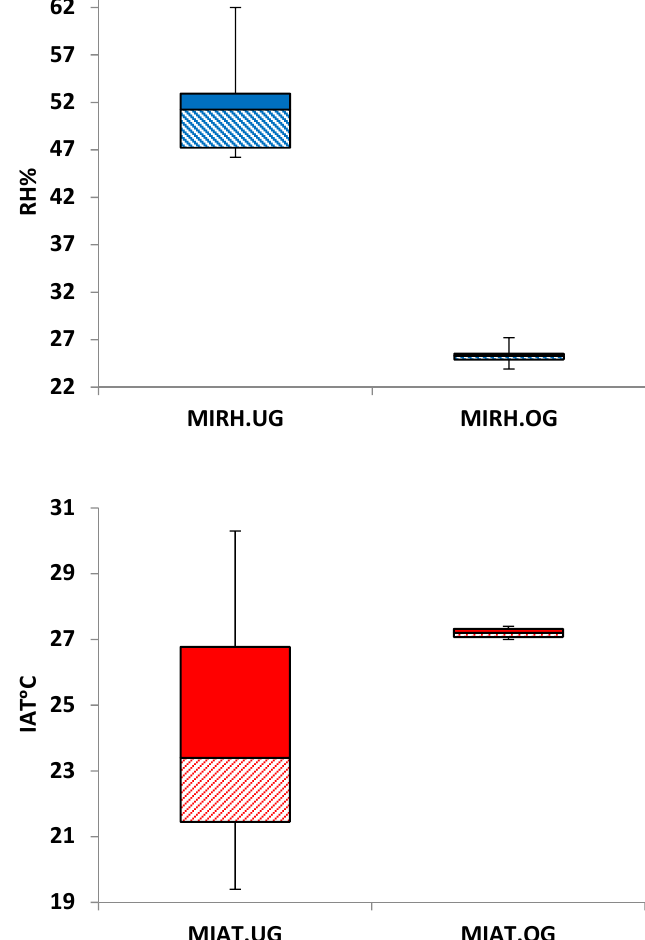
Figure 9. Monitored indoor air temperature and relative humidity for both the underground and above ground rooms over 3 days where, MIRH.US is monitored indoor relative humidity of underground, MIRH.OG is monitored indoor relative humidity of above ground, MIAT.UG is monitored air temperature of underground and MIAT.OG is monitored air temperature of above